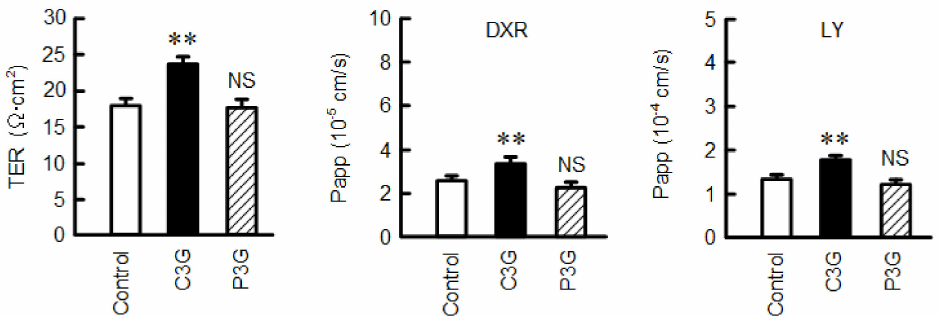
Figure 9. Effect of anthocyanins on the barrier function of TJs. Cells were cultured on transwell inserts and treated with 0 µ M (control), 50 µ M C3G, or 50 µ M P3G for 24 h. TER was measured using a volt-ohmmeter. DXR and LY were applied to the apical compartment. The buffer in the basal compartment was collected after 30 min, and fluorescence intensity was measured. Papp was calculated as described in the method using equation 1. n = 3–4. ** p <0.01 and NS p >0.05 compared with control.